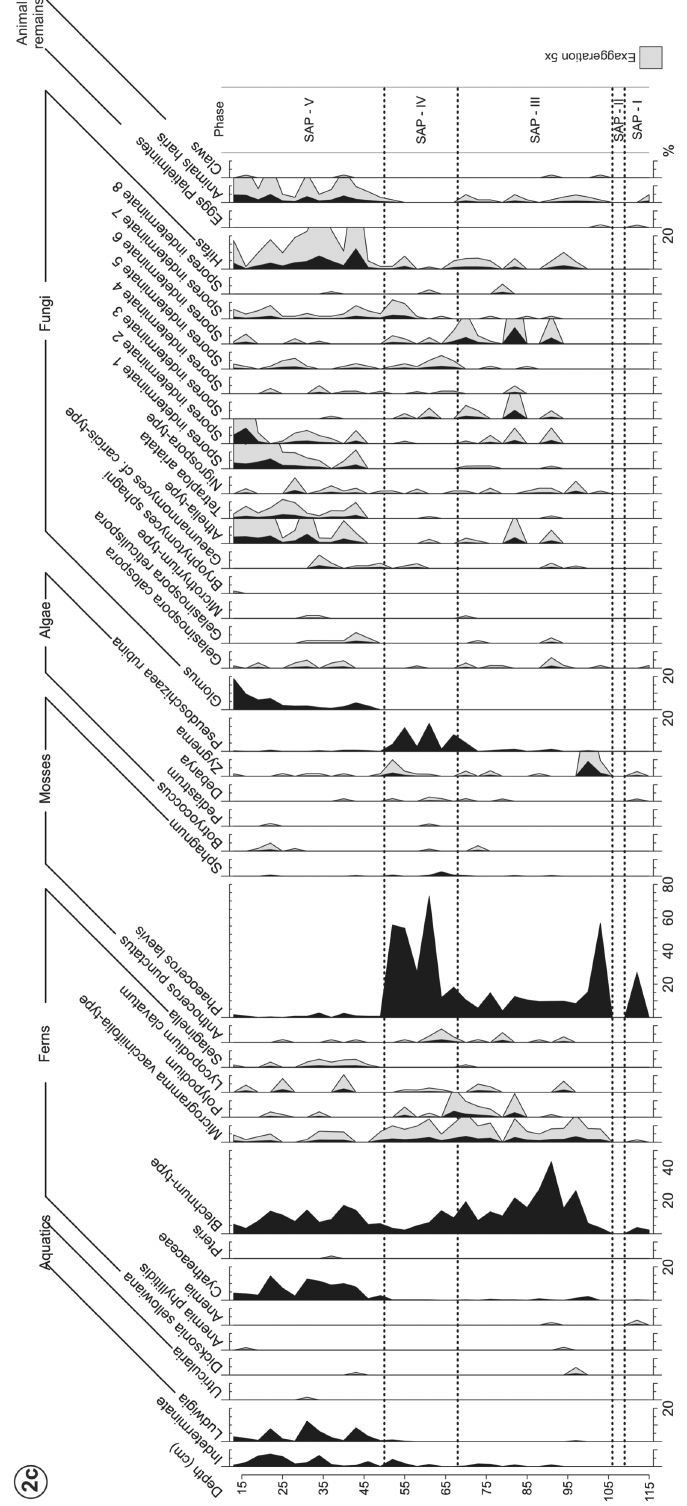
Fig. 2 – (c) Pollen diagram percentages of Aquatics, Ferns, Mosses, Algae, Fungi and Animal remains.